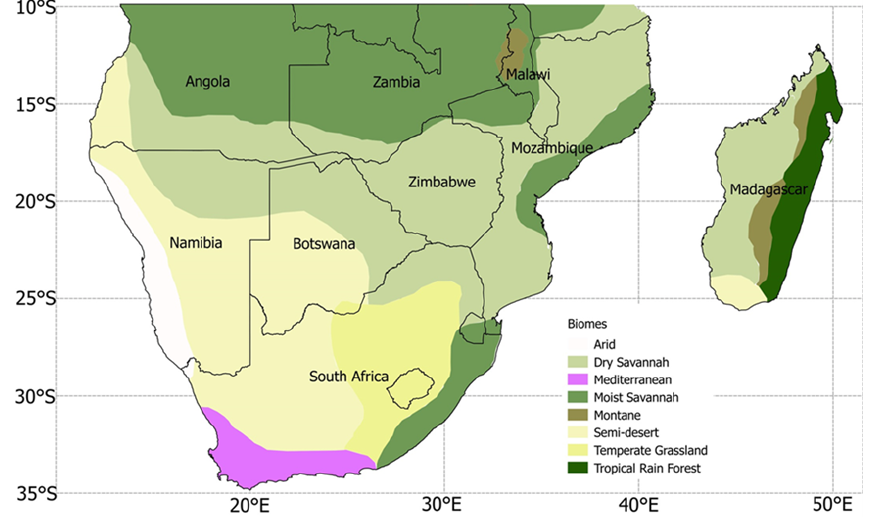
Figure 1. Major vegetation biomes in southern Africa (adapted from UNEP, 2008, Sinclair and Beyers, 2015, and Lawal et al., 2019a, b). The black lines indicate political